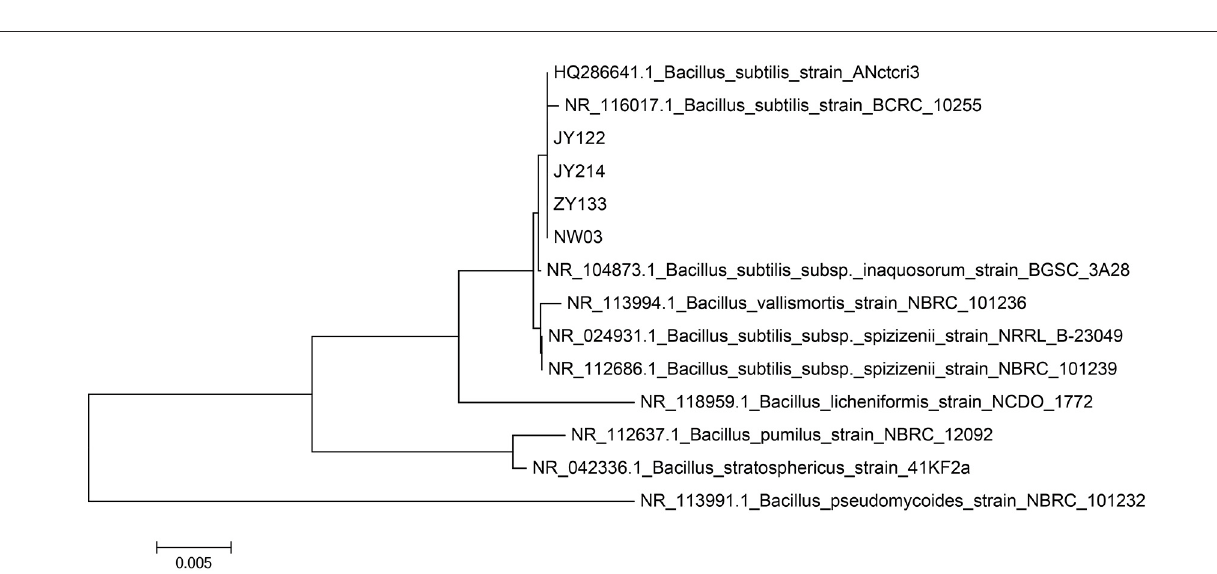
FIGURE3 Phylogenetic analysis of 16s rDNA sequencing results of antagonistic strains. Nucleic sequences from several stains were used for phylogenetic analysis using the maximum likelihood method and JTT matrix-based model. The scale bar indicates the number of nucleic acid substitutions per